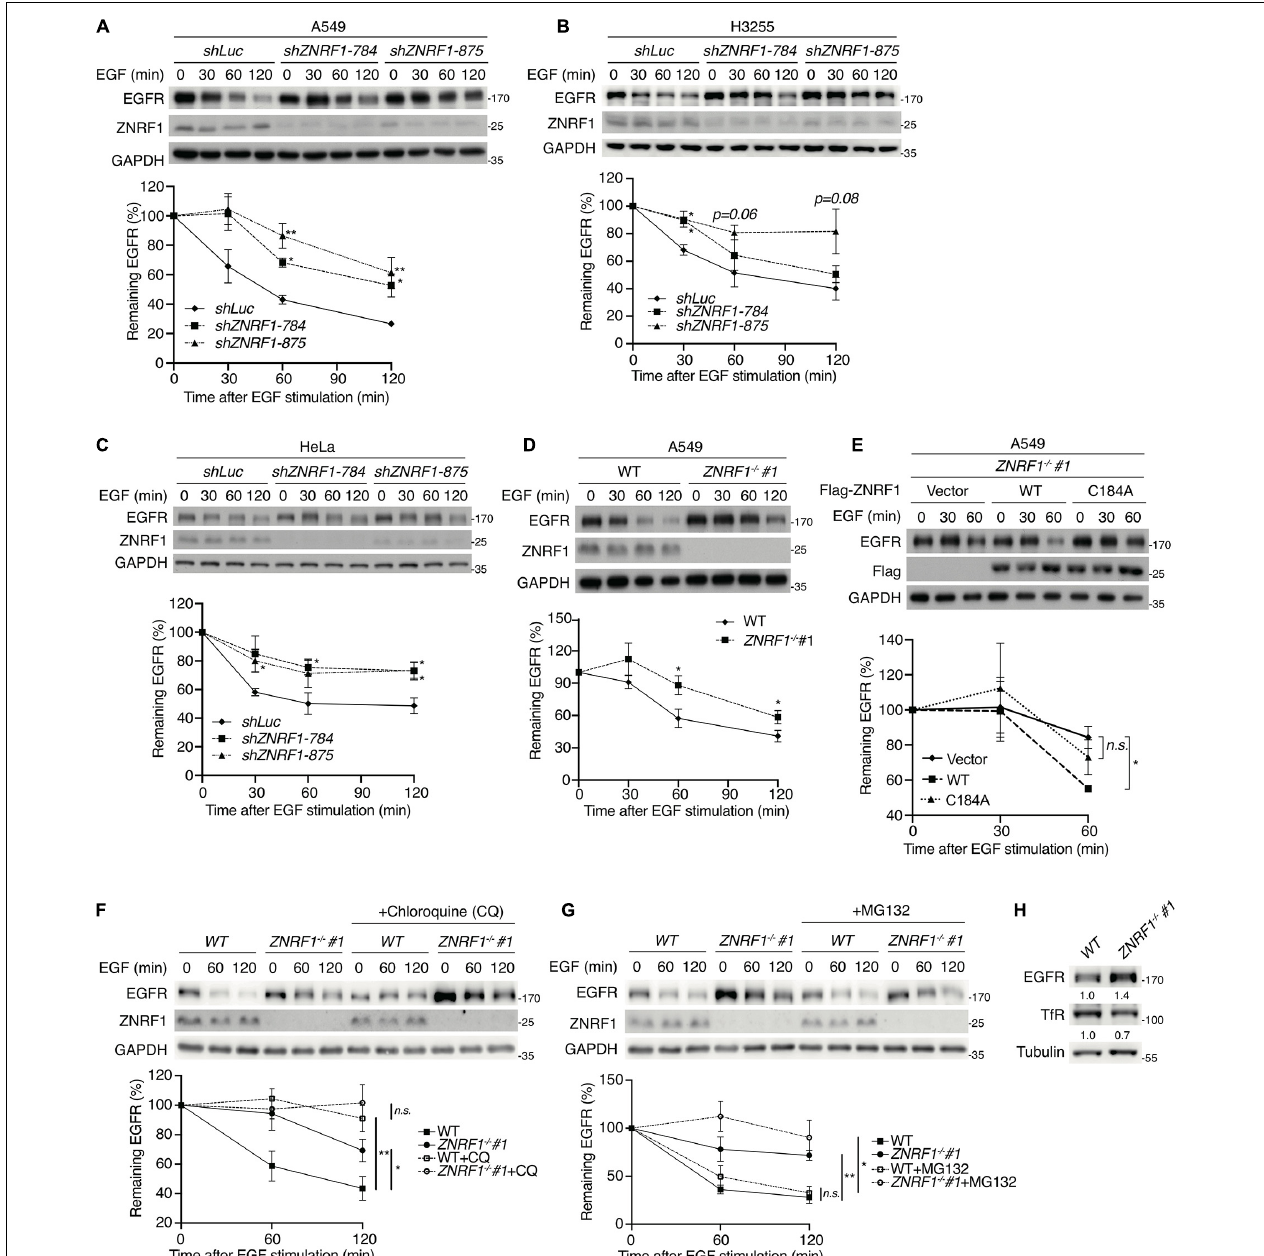
FIGURE 1 | ZNRF1 controls EGFR degradation. (A–E) A549 (A) , H3255 (B) , and HeLa (C) cells infected with lentivirus expressing shRNA against luciferase ( shLuc ) or ZNRF1 ( shZNRF1 ), wild type or ZNRF1 − / − A549 cells (D) , and ZNRF1 − / − A549 cells transduced with lentiviruses encoding empty vector, Flag-ZNRF1 (WT), or Flag-ZNRF1 (C184A) (E) were serum-starved overnight and treated with 100 ng/mL EGF for the indicated times. (F,G) Wild type and ZNRF1 − / − A549 cells were serum-starved overnight. Cells were then pre-treated with or without 100 µ M Chloroquine (F) or 10 µ M MG132 (G) for 1 h and stimulated with 100 ng/mL EGF for the indicated times. Cell lysates were prepared, and the levels of EGFR, ZNRF1 were analyzed by immunoblotting. Quantification of immunoblotting analysis data of three independent experiments are shown in the lower panels. (H) Cell lysates from wild type or ZNRF1 − / − A549 cells were collected and the protein levels of EGFR and TfR were examined by immunoblotting. The intensities of the bands are expressed as fold increases compared to those of control cells (WT) after normalization to tubulin. Results are presented as averages ± SEM. n.s., no significant; * P < 0.05, ** P < 0.01 (Student’s t -test).